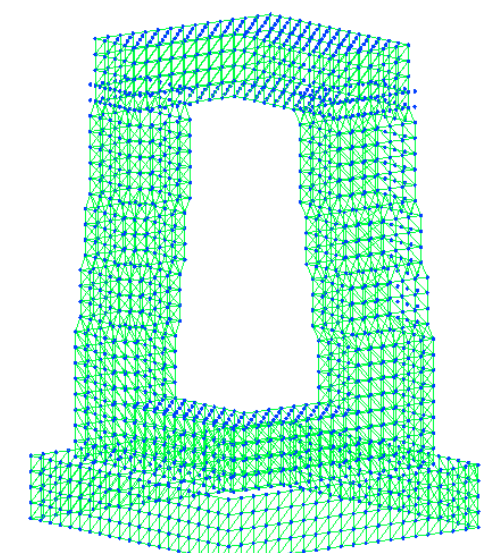
Figure27. Delaunay triangulation (level -5.000) 6. BÉZIER SPLINE